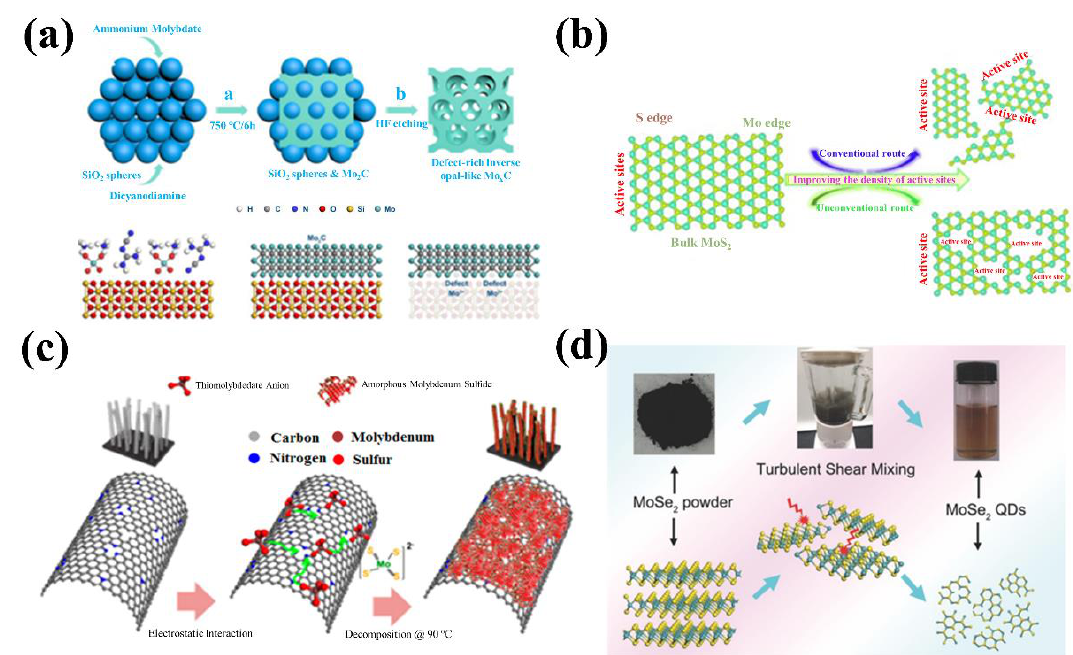
Figure 2. ( a ) schematic illustration for synthesis of inverse opal-like Mo 2 C with SiO 2 spheres and the formation of a rich density of defects. Copyright 2017 American Chemical Society. ( b ) schematic illustration of the formation of active sites in MoS 2 . Copyright 2014 Wiley. ( c ) schematic illustration of three-dimensional hybrid catalyst synthesis. Copyright 2014 American Chemical Society. ( d ) schematic diagram of the TSM (turbulent shear mixing) process for preparing MoSe 2 QDs from bulk MoSe 2 . Copyright 2017 Wiley.